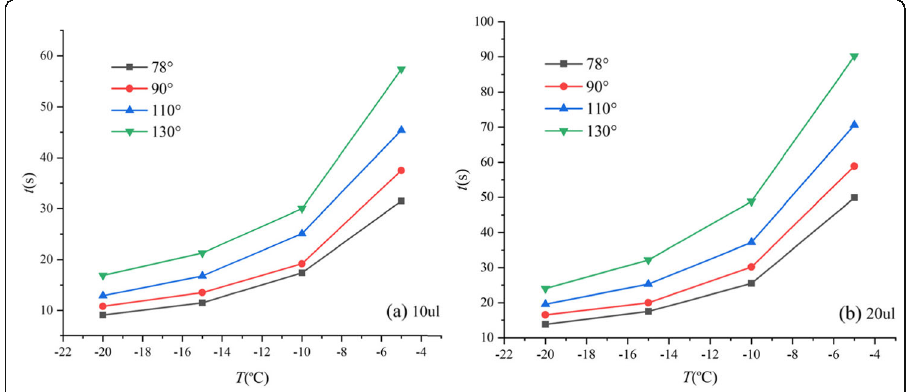
Fig. 6 Freezing time of ( a ) 10ul ( b ) 20ul droplets on cold surfaces with different contact angles varies with wall